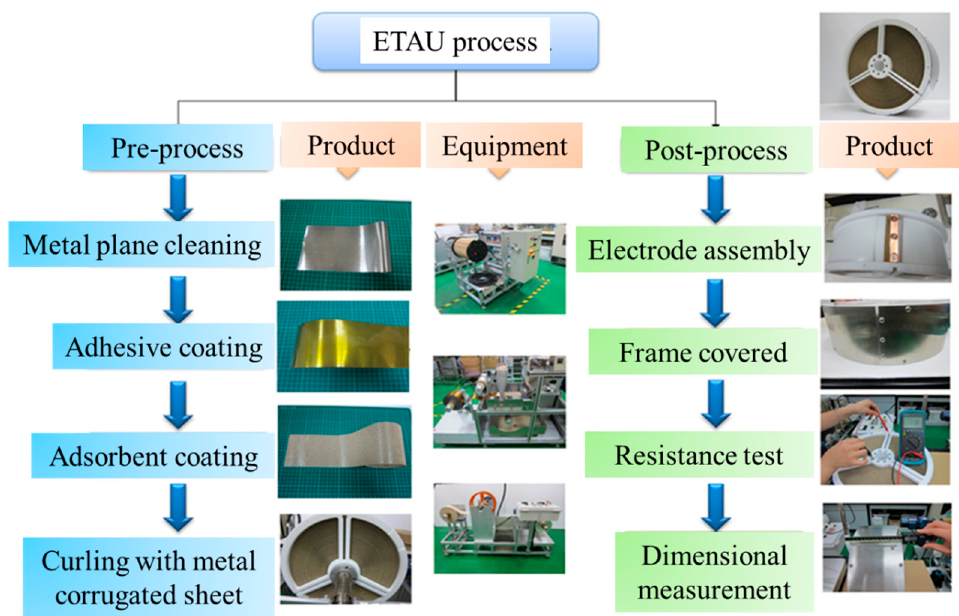
Figure 12. Continuous roll-to-roll ETAU manufacturing procedure.